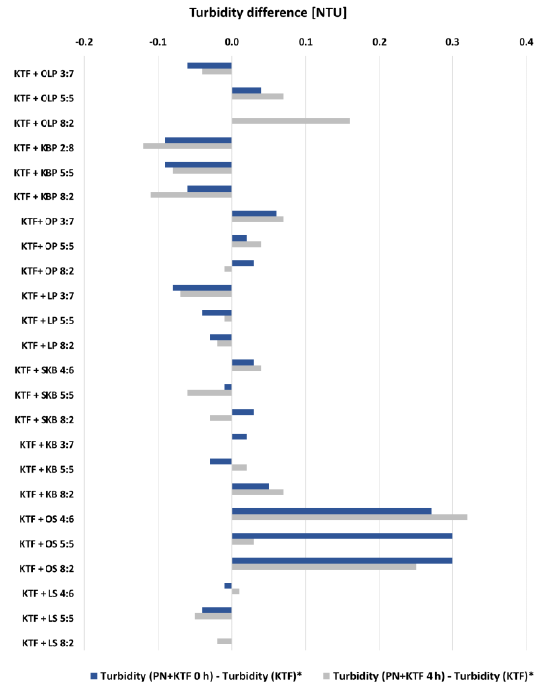
Figure 4. Difference between the turbidity of tested samples at t = 0 h and t = 4 h and the turbidity of KTF. * in the case of KTF + SKB combinations instead of the KTF turbidity the SKB turbidity was